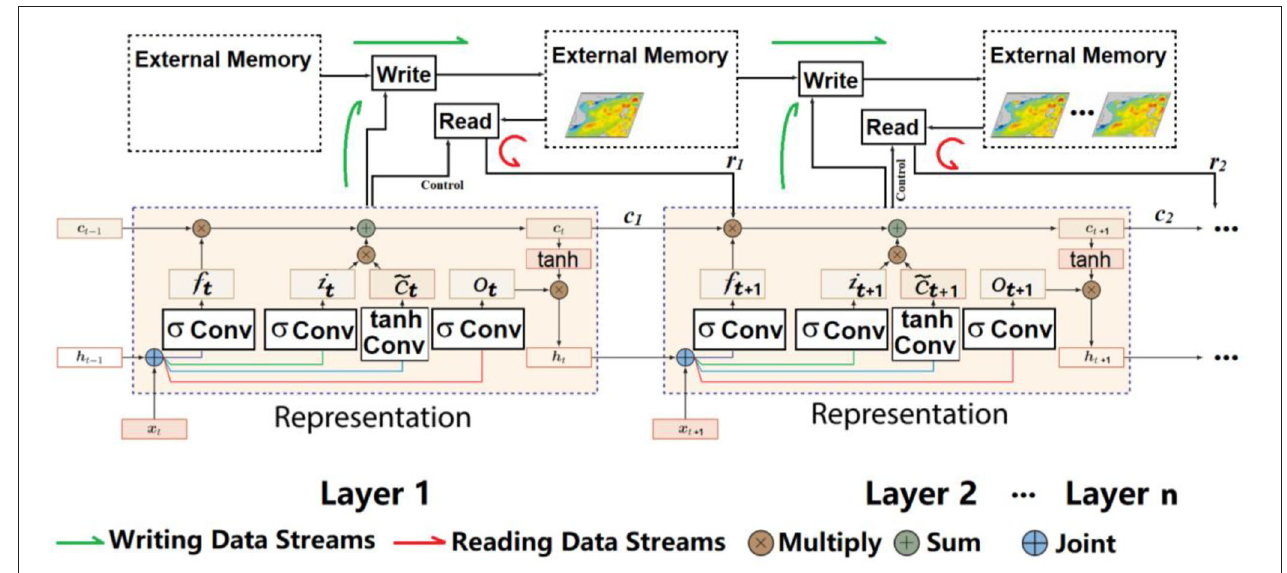
FIGURE 3 | The sketch block diagram of